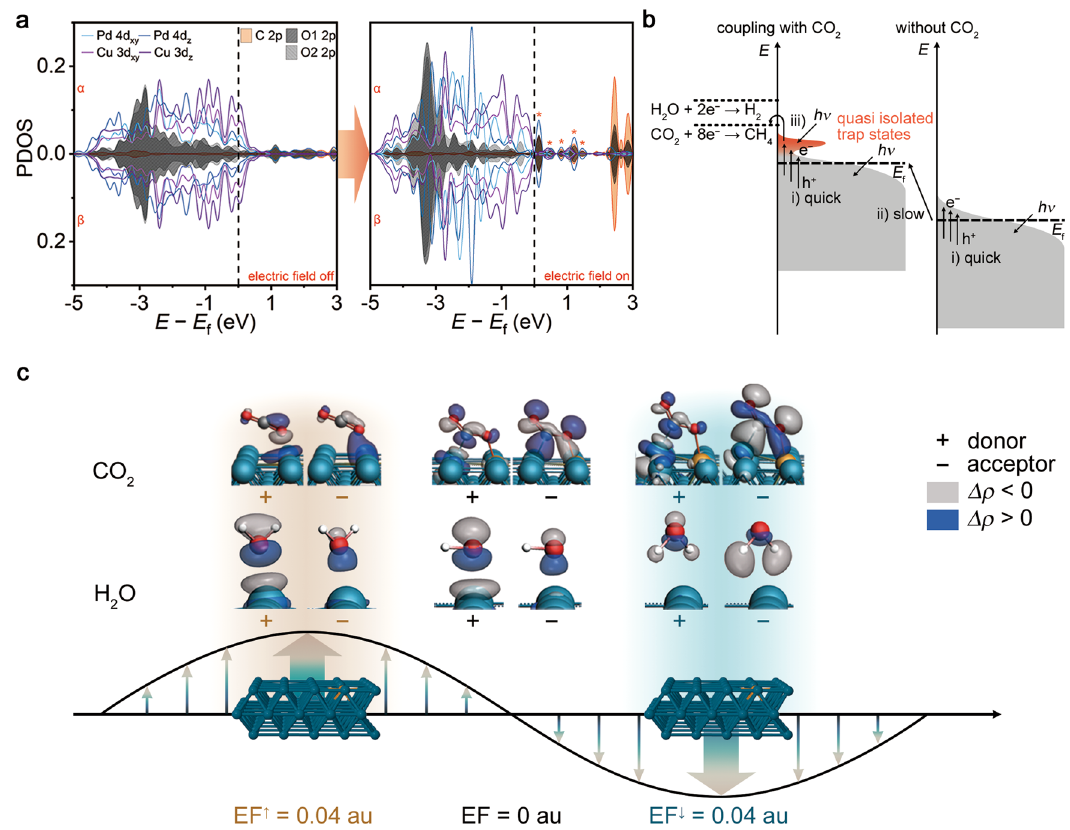
Fig. 3 | Theoretical calculations: the key role of local fi eld in multiphoton absorption and energy transfer processes. a The projected density of states (PDOS)ofCO 2 adsorbedonaCuPd(100)surfaceintheabsence(left)andpresence (right) of electric fi eld pointing toward the surface. The main quasi isolated trap states are marked with orange asterisks. b Schematic illustration for the plasmon- induced energy transfer in CO 2 RR, where the y -axis is energy ( E ) and the gray shading indicates fi lled electronic states. Three key processes for initiating and enhancingtheplasmon-inducedCO 2 RRinclude(i)fastexcitationandaccumulation